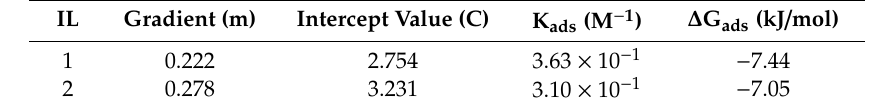
Table 4. Results of the adsorption mechanism determination of IL1 and IL2 following the Temkin isotherm model.